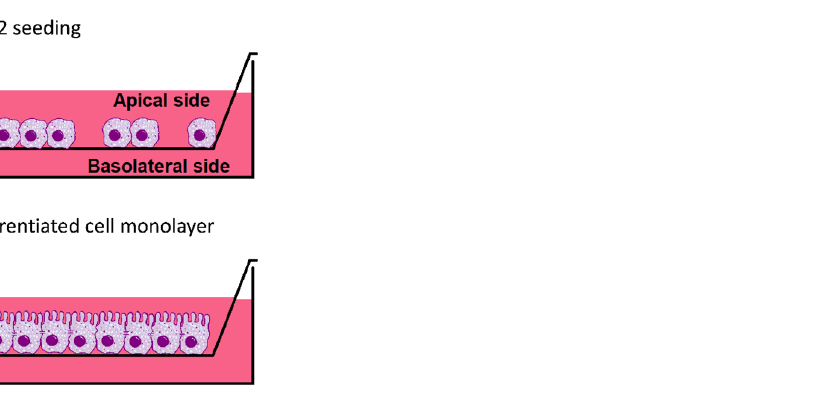
Scheme 2. Representation of the Caco-2 seeding and differentiation after 21 days to intestinal barrier in vitro model.